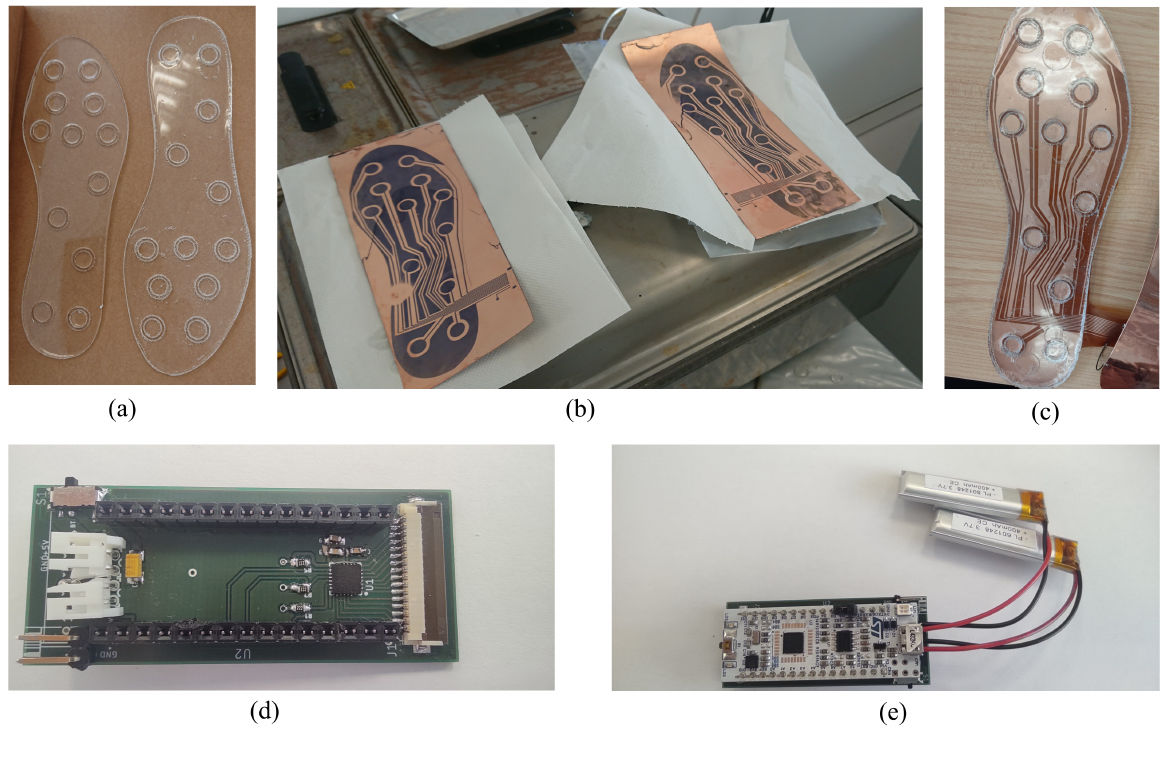
Figure 4. Prototype components: ( a ) PDM-based dielectric layer; ( b ) flexible PCB with remaining photoresist ink, prior to copper-dissolution step; ( c ) the insole with three layers finished, prior to fixing them with Kapton; ( d ) ACShield built to house the CDC Controller Ad7147-1 and to connect both plantar insole, batteries, bluetooth and MCU to the whole system; ( e ) ACShield with MCU and batteries